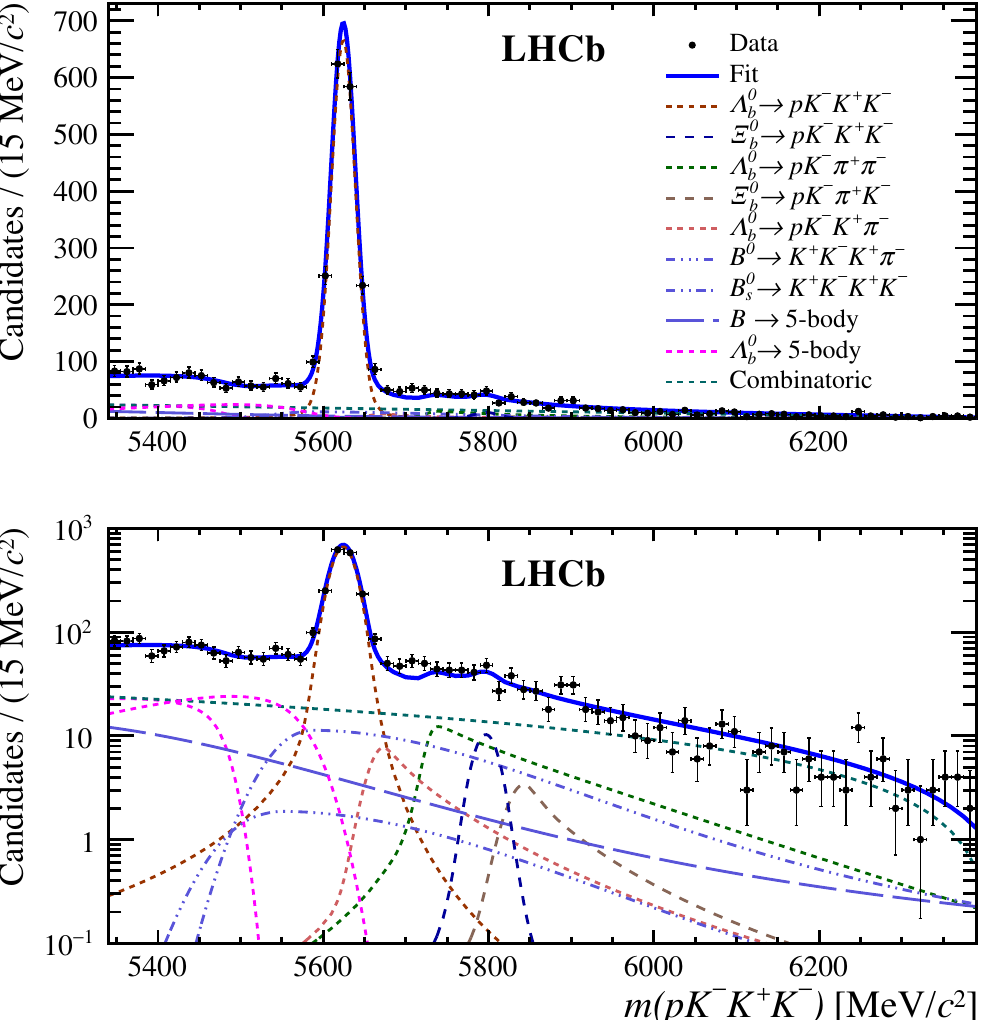
Figure 5 . Results of the (cid:12)t to the pK (cid:0) K + K (cid:0) candidate mass spectrum with (top) linear and (bottom) logarithmic scales. The di(cid:11)erent components employed in the (cid:12)t are indicated in the legend. The (cid:3) 0 ! 5-body legend includes two decays, partially reconstructed (cid:3) 0 b and (cid:3) 0 ! pK (cid:0) K + K (cid:0) (cid:25) 0 , where the (cid:13) and (cid:25) 0 are not b